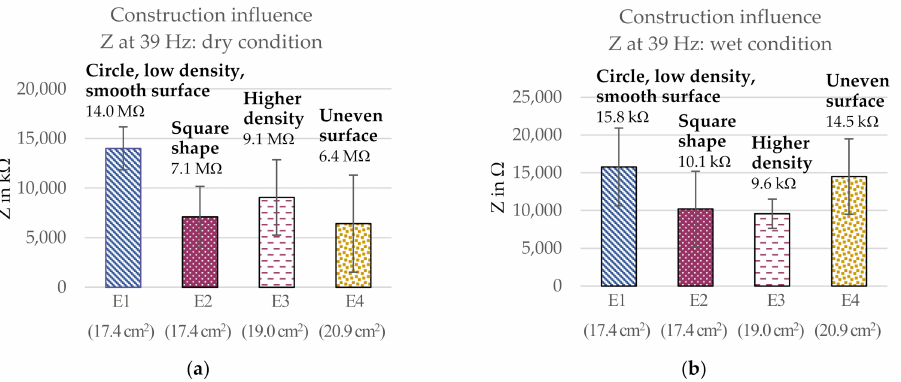
Figure 8. Influence of the electrode construction on the three-electrode contact impedance at 39 Hz in ( a ) dry condition and ( b ) wet condition. SD indicated with error